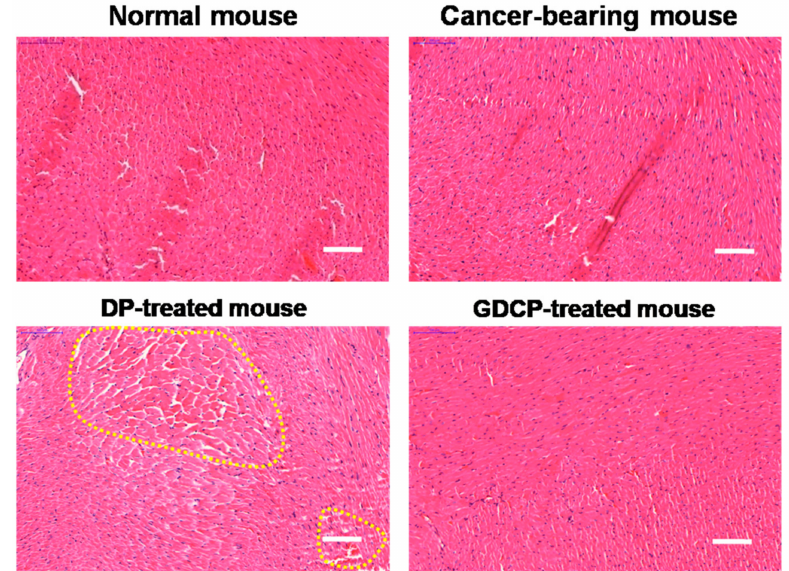
Figure 6. H&E-stained slides of hearts extracted at Day 7 from normal, cancer-bearing, and DP and GDCP-treated mice. Yellow dotted lines indicate abnormal cardiotoxicities including disorganization of the myocardium and myofibrillar fragmentation. Scale bar indicates 100 µ